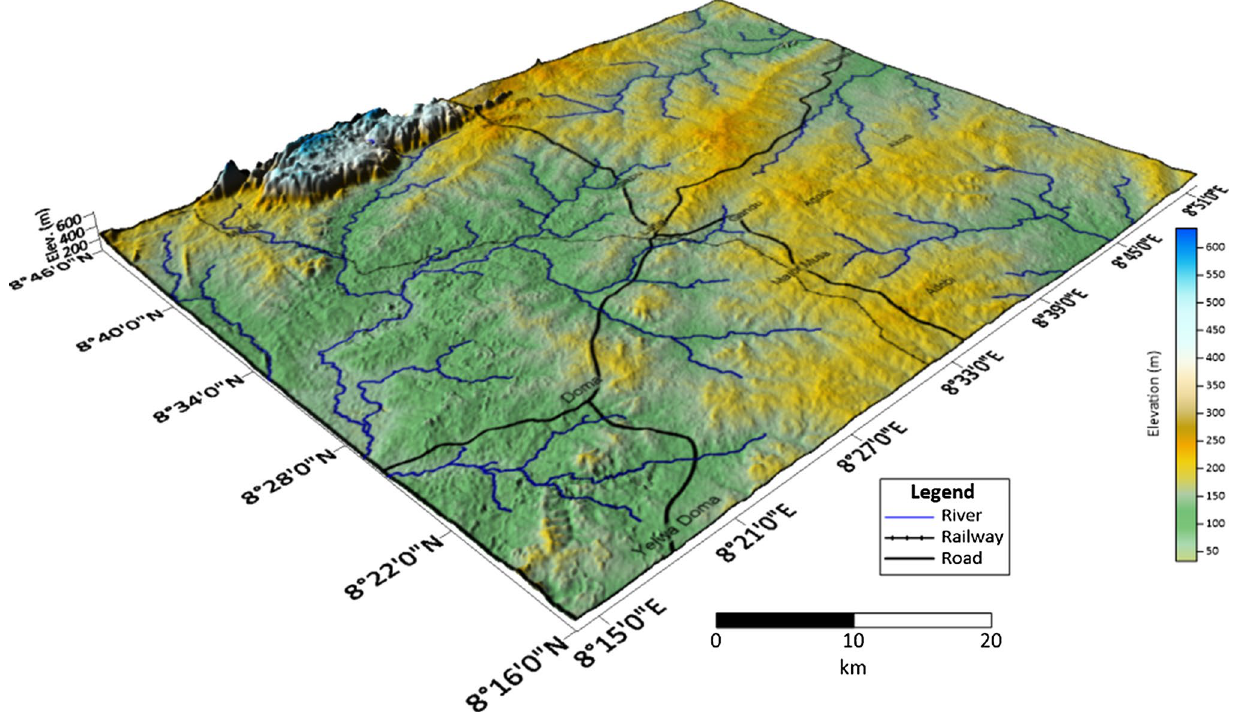
Fig. 1 3D Topographic map of the study